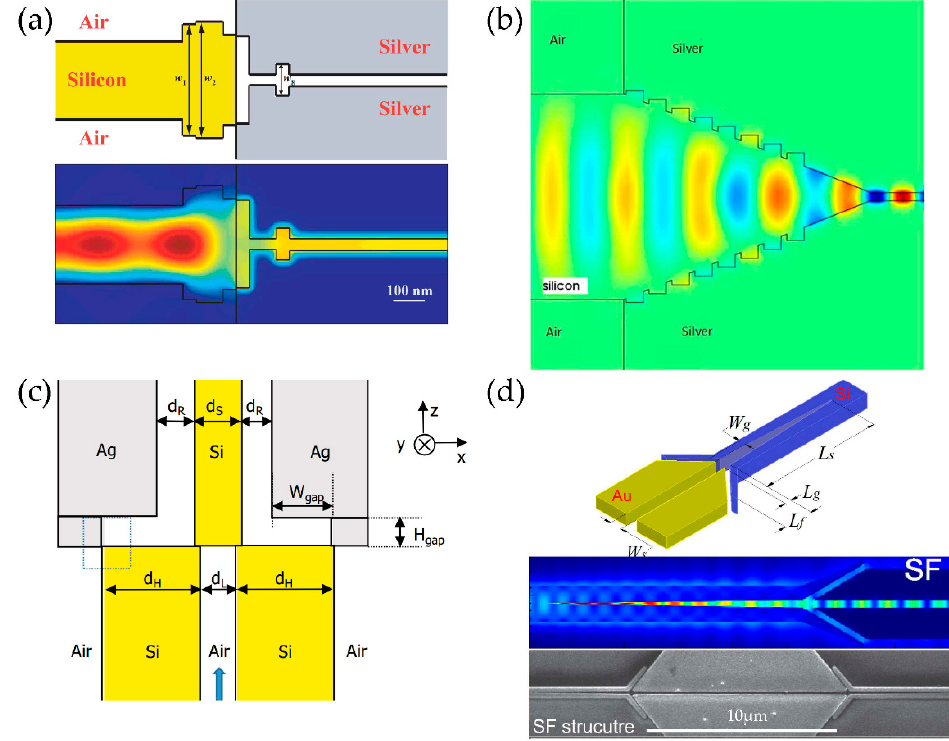
Figure 9. Some more complicated tapered coupling designs with simulated coupling efficiencies of ( a ) 93% [127], ( b ) 93% [143], ( c ) 90% [130], and experimentally measured coupling loss of ( d ) 4 dB [132]. Figures reproduced from ( a ) [127]; ( b ) [143]; ( c ) [130]; ( d ) [132].